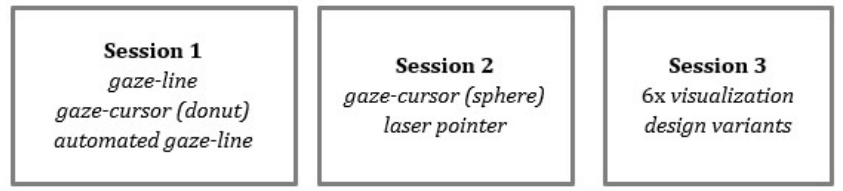
Figure 5. The overview of the independent variables in the three sessions of the